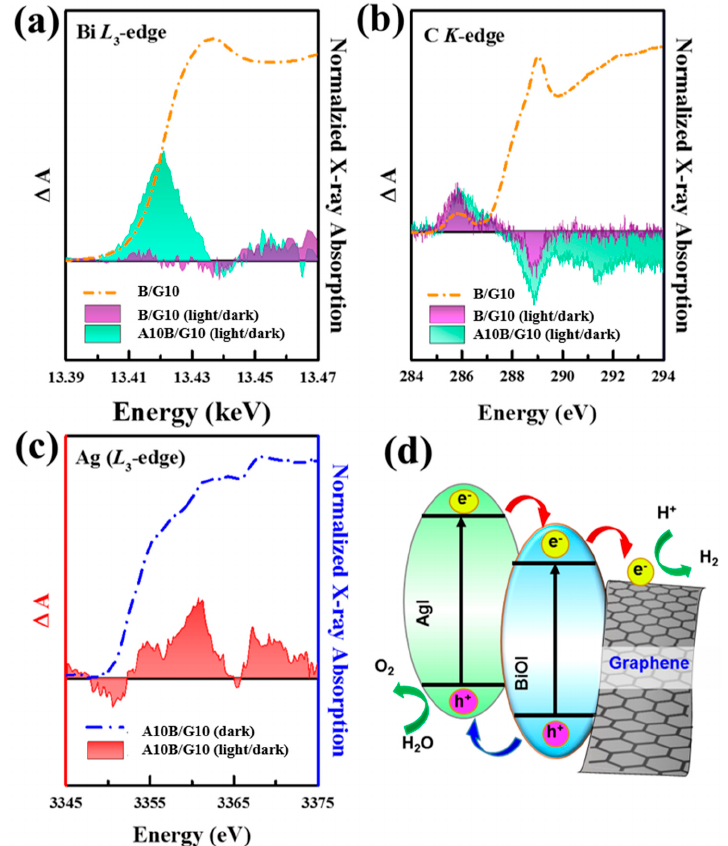
Figure 3. Intensity change between the irradiated and dark states of ( a ) Bi l L 3 -edge, ( b ) C K -edge, and ( c ) Ag L 3 -edge. ( ∆ A = A light − A dark ) of B/G10 and A10B/G10 photocatalysts, ( d ) a proposed mechanism for the photocatalytic H 2 generation reaction by A10B/G10 [47].